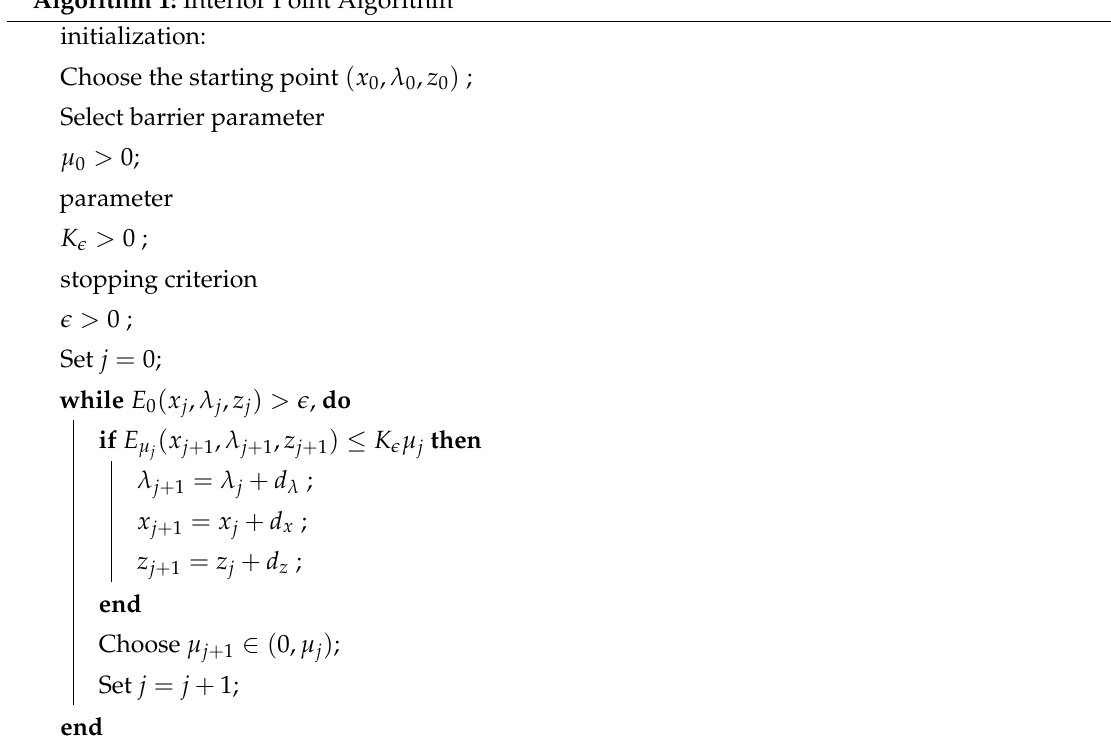
Algorithm 1: Interior Point